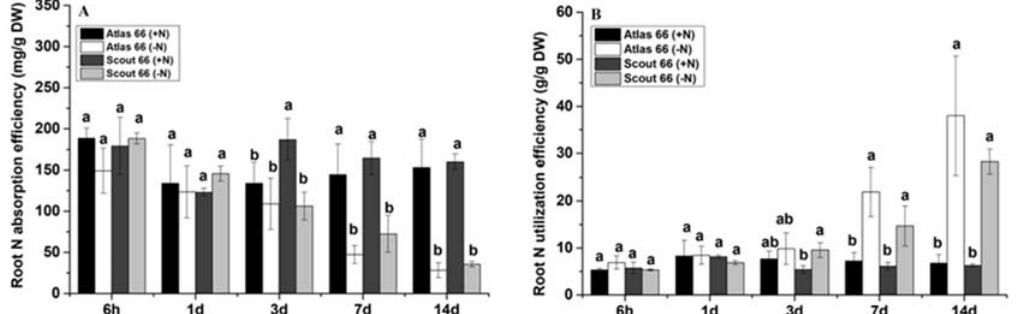
Figure 3. Effect of N deficiency on wheat plant root N absorption efficiency ( A ) and root N utilization efficiency ( B ). Wheat plants were transferred from N sufficiency to either N sufficient (2 mM) or deficient (50 μ M) conditions for a defined treatment time, and the data presented here were sampled from a 6 h to 14 d time point from both N levels. Bars represent the mean ± SD ( n = 3). Different small letters indicate statistically significant differences, based on LSD tests ( p ≤ 0.05) among the treatments and cultivars.